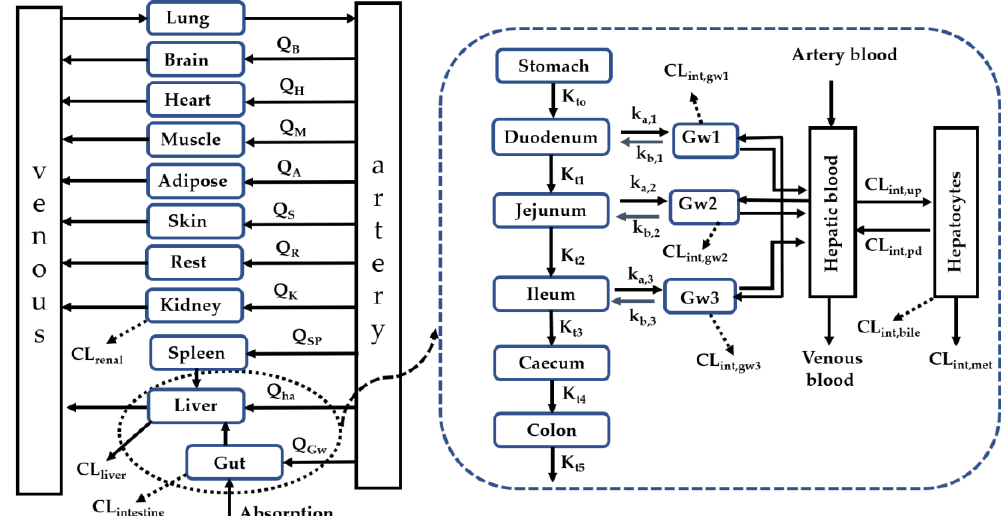
Figure 5. Schematic diagram of the whole PBPK model involving both enzyme and transporter turnover. Q i indicated blood flow in the corresponding compartment. CL is the intrinsic clearance. G wi is the i-th enterocyte compartment. K ti , k a,i and k b,i represented the transit rate constant, drug absorption rate constant and e ffl ux rate constant from enterocyte to gut lumen, respectively. CL int, up , CL int, pd